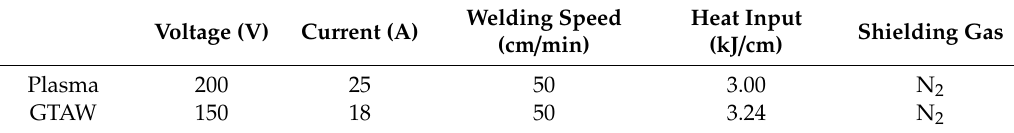
Table 2. GTAW and plasma automatic welding process conditions.